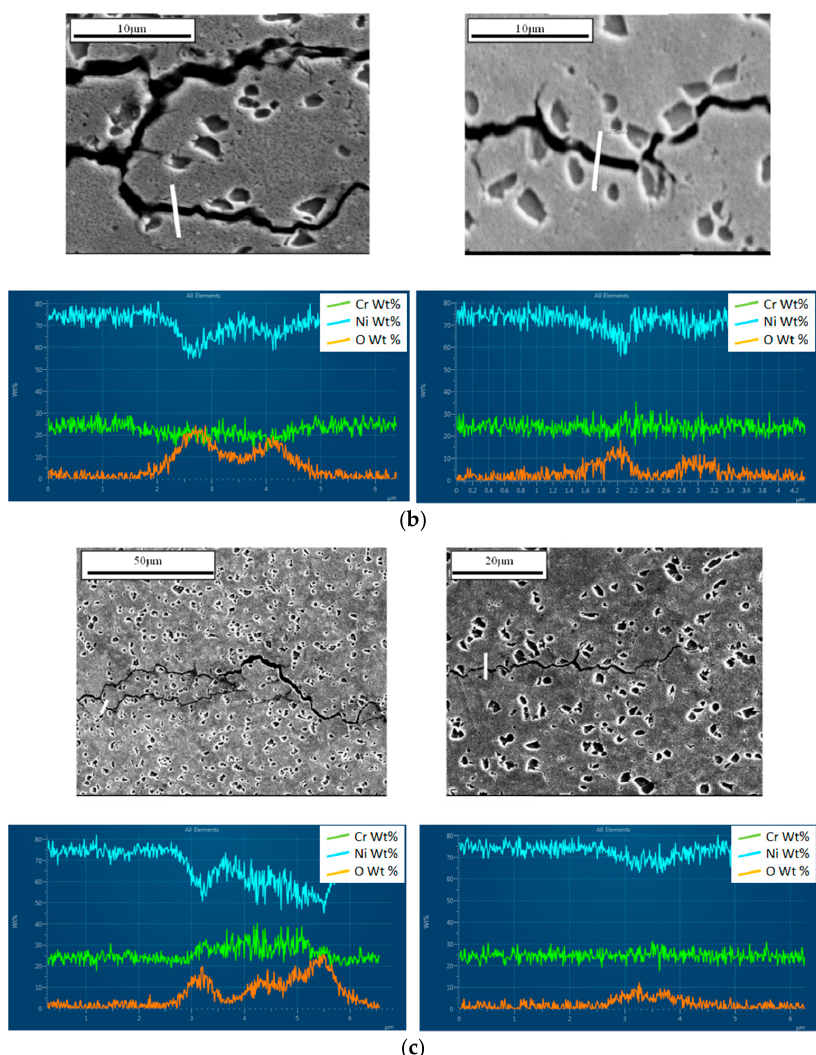
Figure 21. Energy dispersive X-ray spectroscopy (EDX) line scans taken near the start of the test and near the crack tip for ( a ) ACW 80-s cycle; ( b ) CW 80-s cycle and ( c ) ACW 500-s cycle.